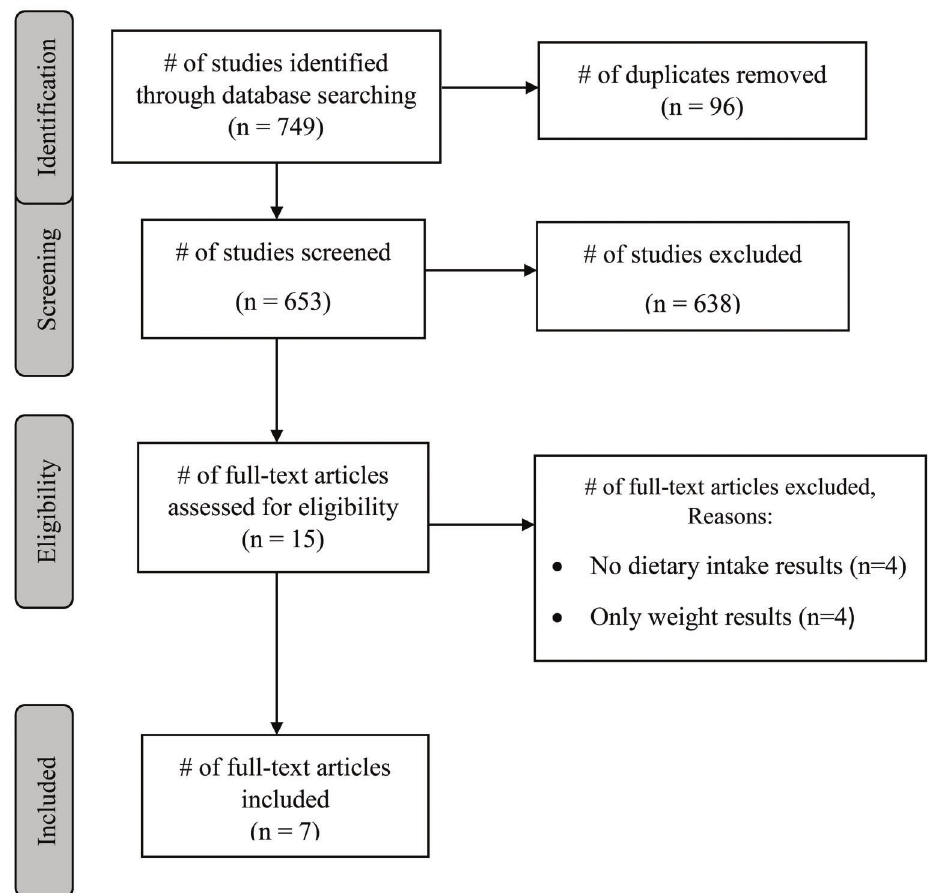
Figure 1. Flow diagram of study